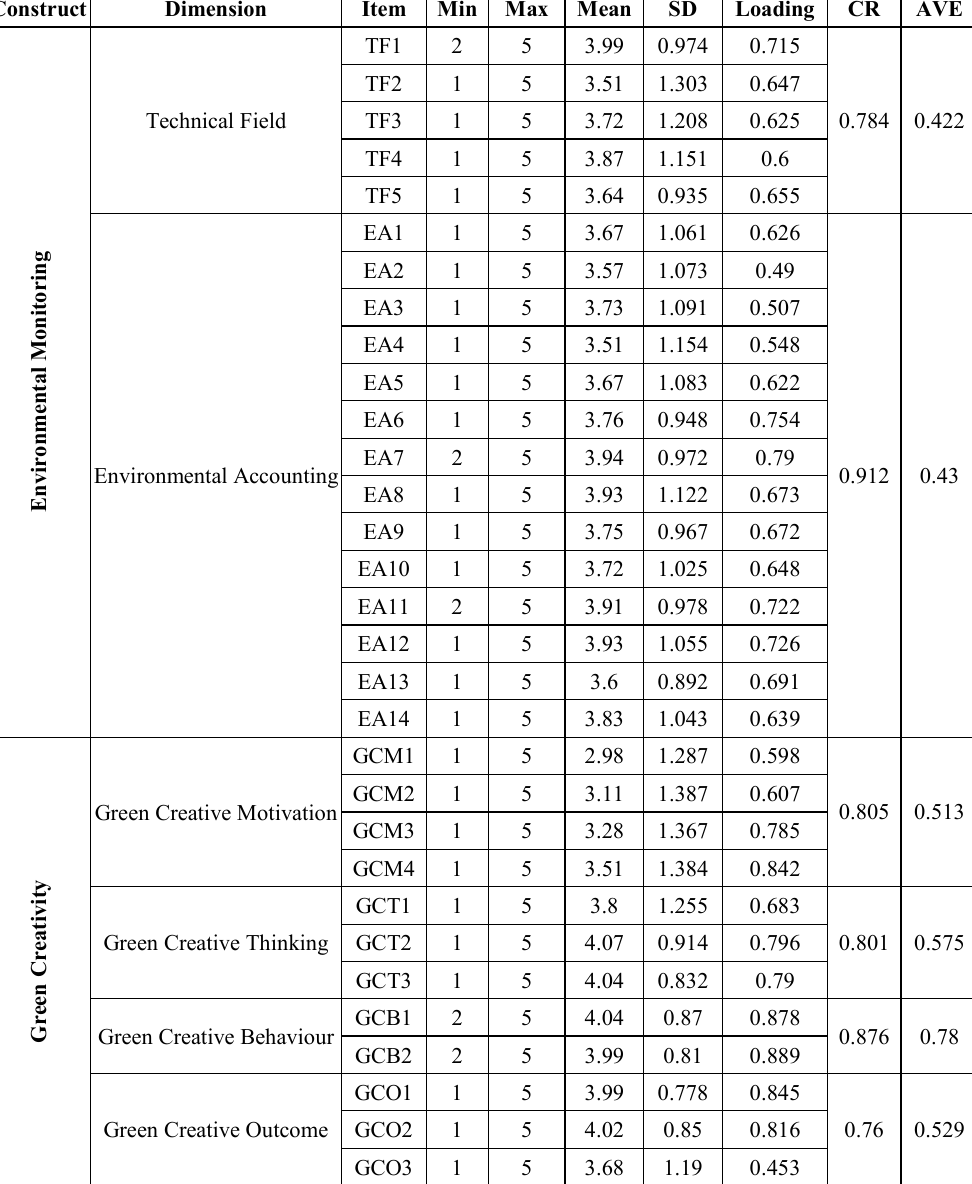
Table 2. Descriptive Statistics, Reliability and Validity